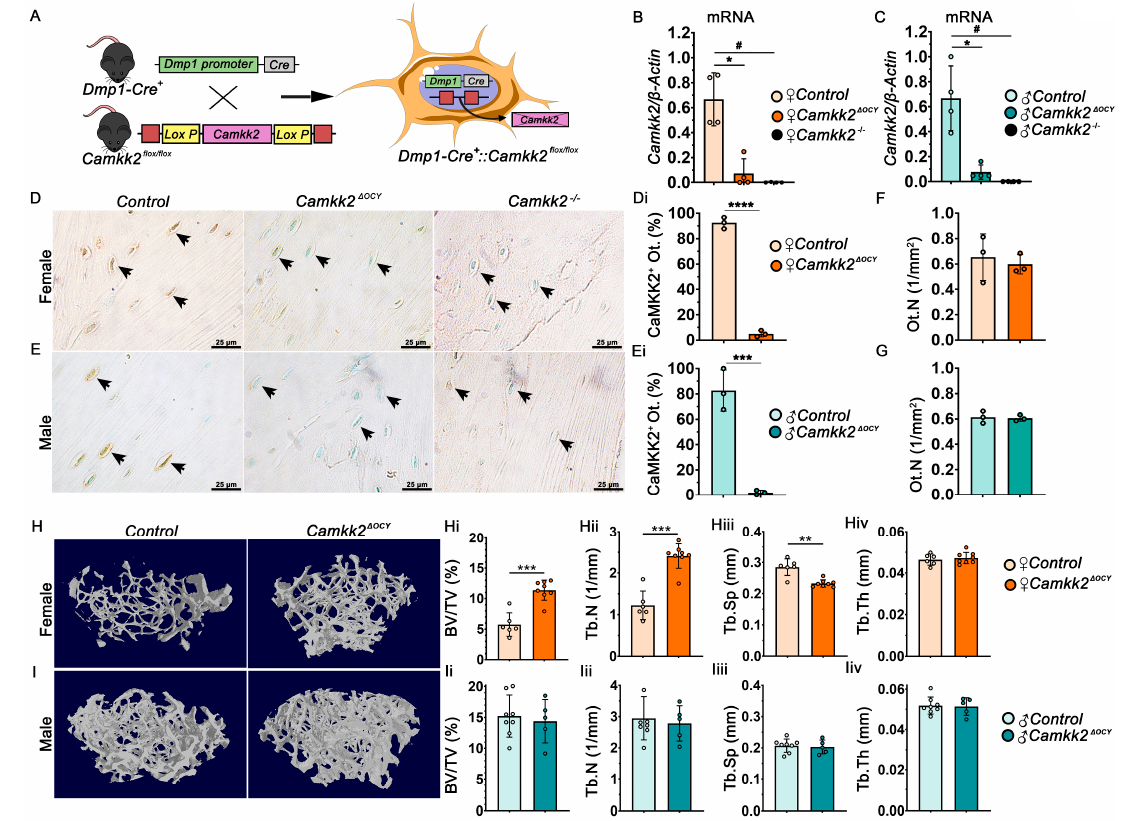
Figure 1. CaMKK2 deficiency in osteocytes enhances trabecular bone mass in female but not male mice. ( A ) Diagram illustrating the breeding scheme for the generation of the mouse model with osteocyte-targeted deletion of CaMKK2. ( B , C ) Normalized Camkk2 expression relative to β -actin in primary osteocytes isolated from the long bones of female and male control, Camkk2 Δ OCY and Camkk2 - /- mice ( n = 4 individual mice/group). ( D , E ) Representative IHC images ( n = 3; magnification X 630) of CaMKK2 immunostaining in femoral cortical bone of female and male control (Camkk2 WT/WT ) , Camkk2 Δ OCY and Camkk2 -/- mice. ( Di , Ei ) CaMKK2-immunopositive osteocytes (CaMKK2 + Ot) shown as percentage of total osteocytes. ( F , G ) Total number of osteocytes (N.Ot/mm 2 ) enumerated from female and male control and Camkk2 Δ OCY long bones ( n = 3/group). ( H , I ) Representative 3D models of cancellous bone microarchitecture in the distal femur of female and male control and Camkk2 Δ OCY mice. ( Hi , Ii ) Mean percent bone volume (BV/TV); ( Hii – Hiv , Iii – Iiv ) number of trabeculae (Tb.N), spacing between trabeculae (Tb.Sp), and thickness of trabeculae (Tb.Th) within the distal femur of female and male control and Camkk2 Δ OCY mice ( n = 5–8/group). Error bars represent SD. * denotes statistical comparisons between control and Camkk2 Δ OCY mice; * p < 0.05, ** p < 0.01, *** p < 0.001, **** p < 0.0001. # = p < 0.05 – statistical comparisons between control and Camkk2 -/- mice.